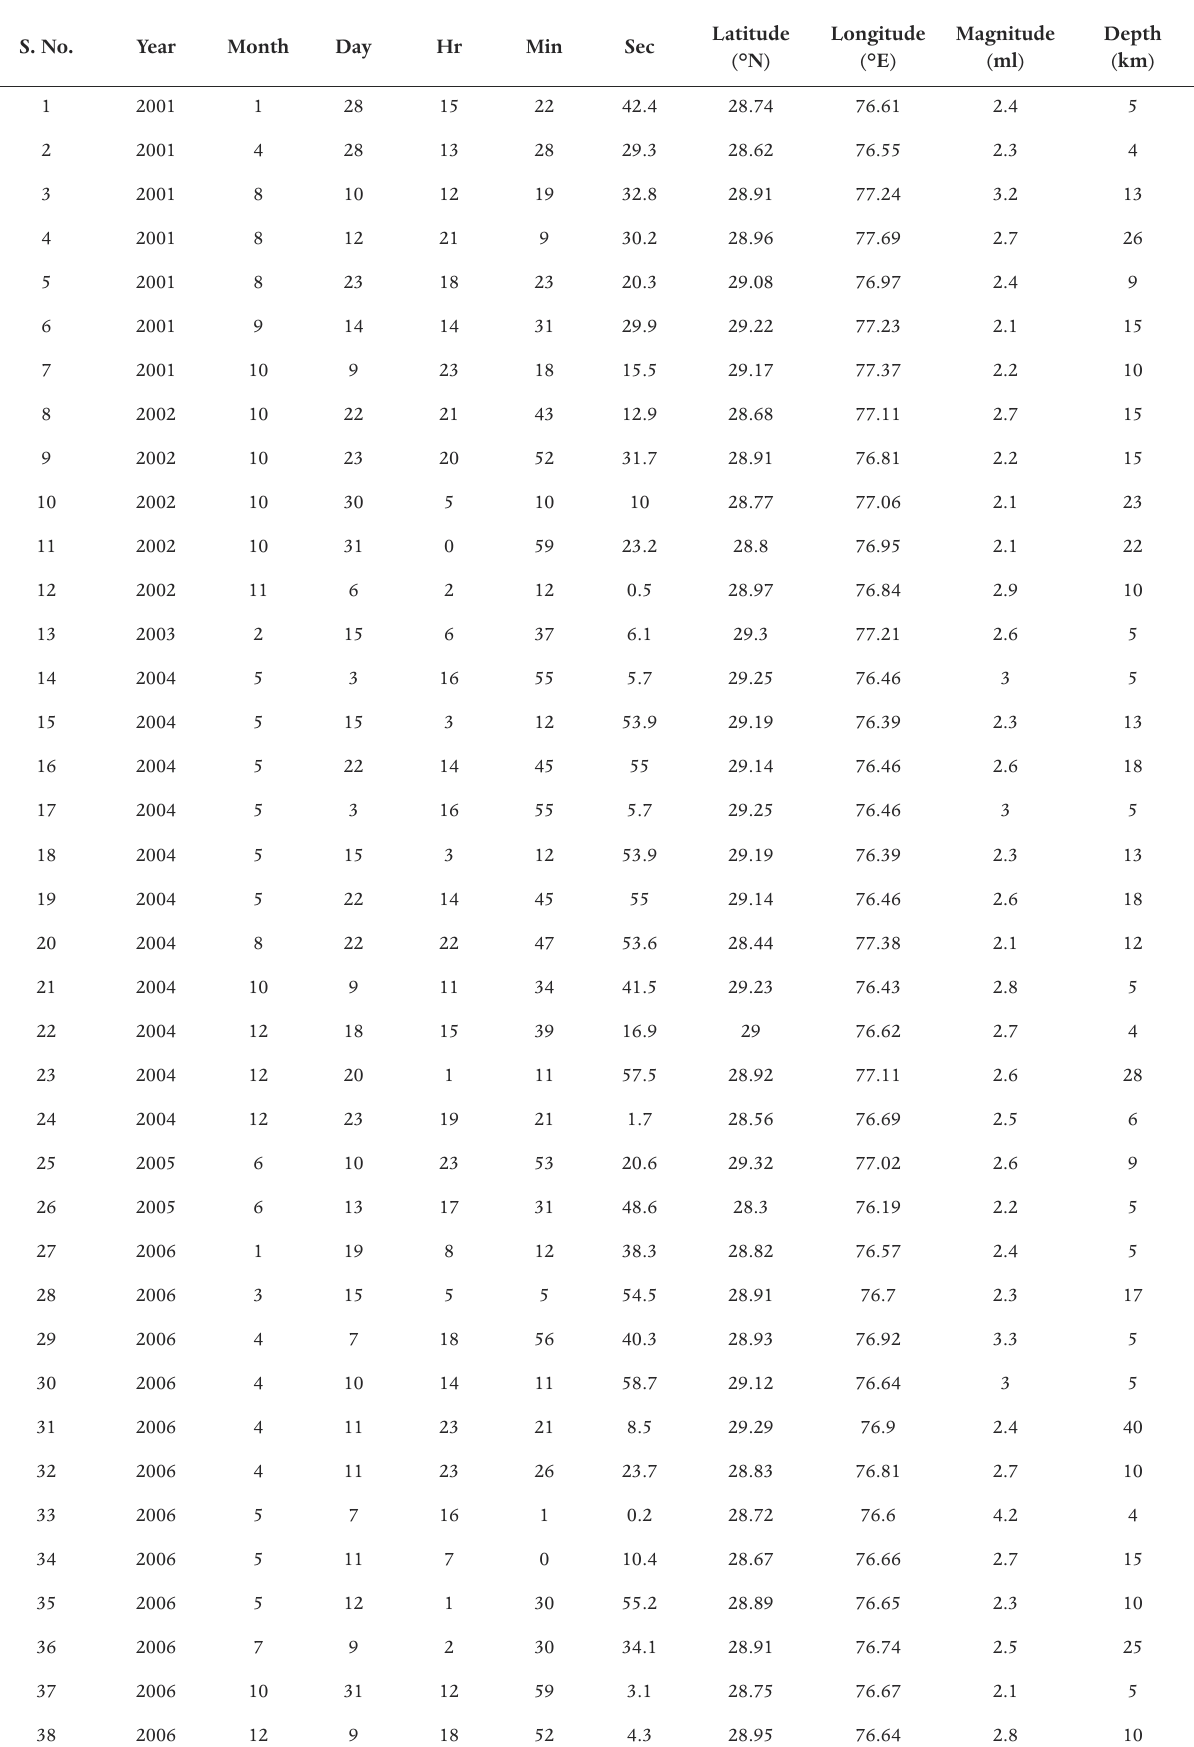
Table 2 (continues on next page). Coordinates of the stations along with their station codes in and around Delhi